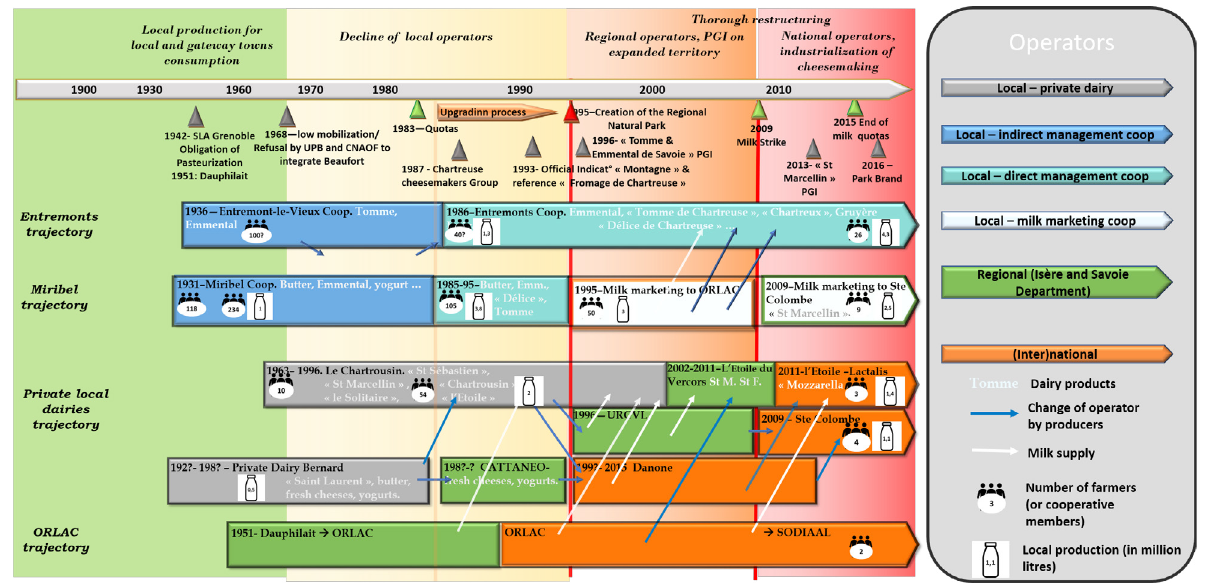
Figure 1: Timeline of the Chartreuse dairy value